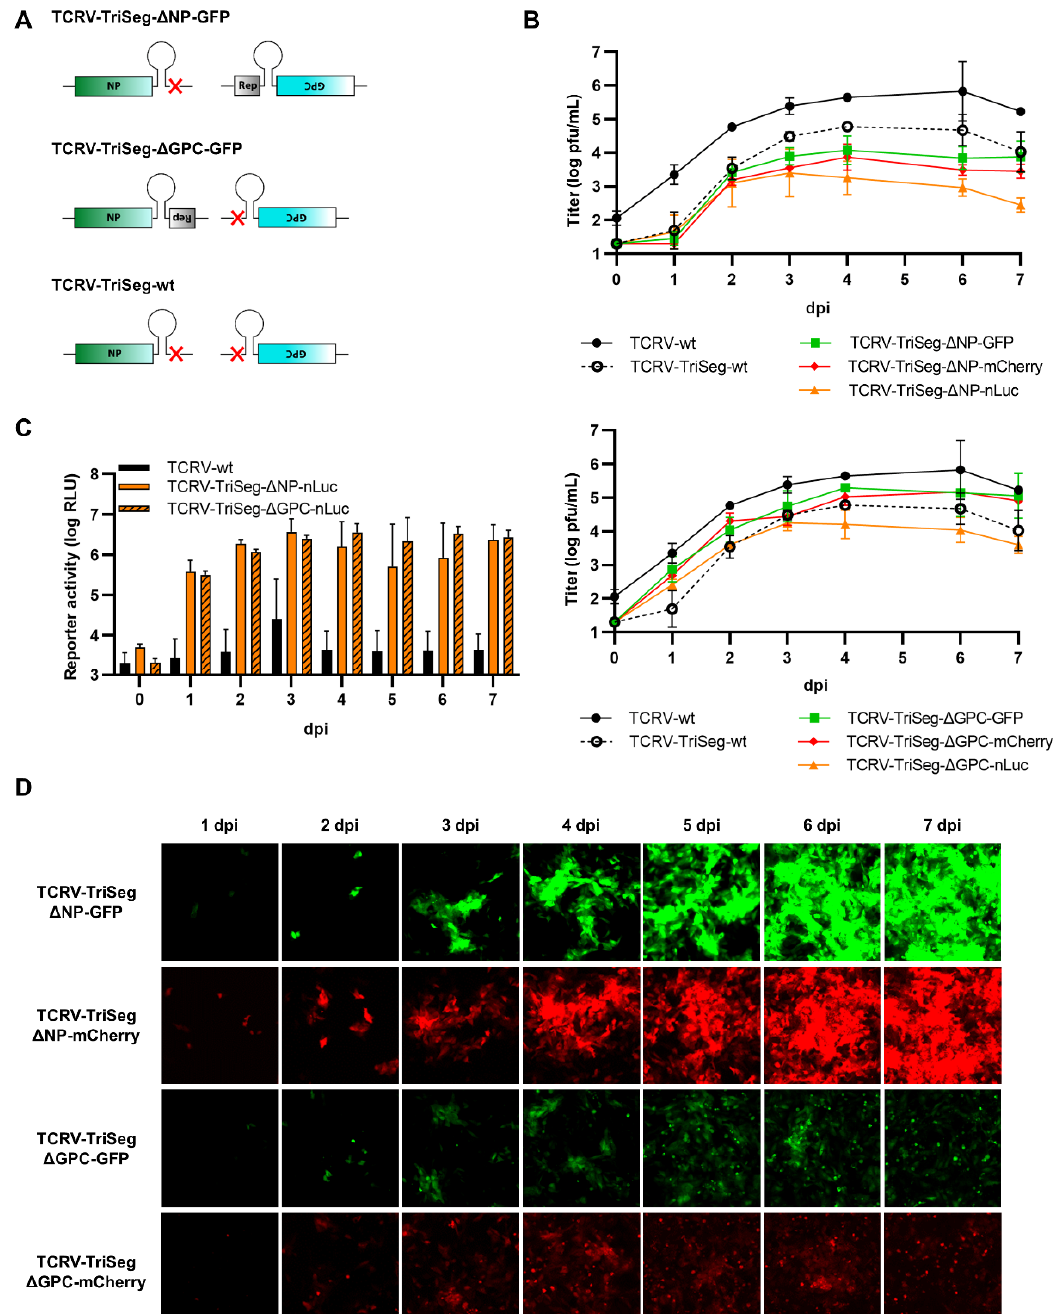
Figure 1. Reporter-expressing trisegmented Tacaribe virus (TCRV). ( A ) Schematic representation of trisegmented TCRV genomes. TCRV-TriSeg- ∆ NP-reporter viruses have a wild-type (wt) Lseg and two Sseg: one in which the NP ORF has been replaced by the reporter and one in which the GPC ORF has been deleted (top). TCRV-TriSeg- ∆ GPC-reporter viruses have a wt Lseg and two Sseg: one in which the GPC ORF has been replaced by the reporter, and one in which the NP ORF has been deleted (middle). The TCRV-TriSeg-wt virus has a wt Lseg and two Sseg: one in which the NP ORF has been deleted and one in which the GPC ORF has been deleted (bottom). ( B ) Growth kinetics. Vero76 cells were infected at MOI = 0.005 with TCRV-TriSeg- ∆ NP-reporter viruses (top) or TCRV-TriSeg- ∆ GPC-reporter viruses (bottom). Supernatants were harvested on the indicated days, and titrated by plaque assays. Results are shown as mean ± SD of two independent experiments. ( C ) Reporter activity (nLuc). Cells infected as in ( B ) were lysed in 1% Triton on the indicated days, and nLuc activity in lysates was measured. Results are shown as mean ± SD of three independent exper- iments. ( D ) Reporter activity (GFP/mCherry). Pictures of cells infected as in ( B ) were taken on the indicated days, at 10× magnification. Results are shown as representative images from one experi- ment out of two independent experiments.